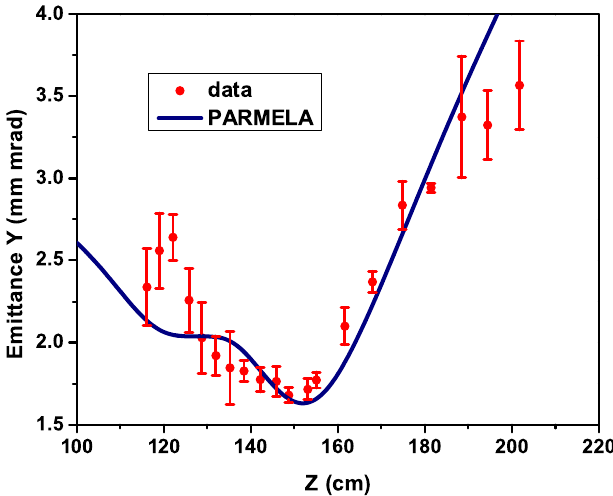
FIG. 18. (Color) Vertical emittance versus z for run #29. This is the measurement with the highest brightness of about 7 (cid:4) 10 13 A = mm 2 . A PARMELA simulation is also shown.